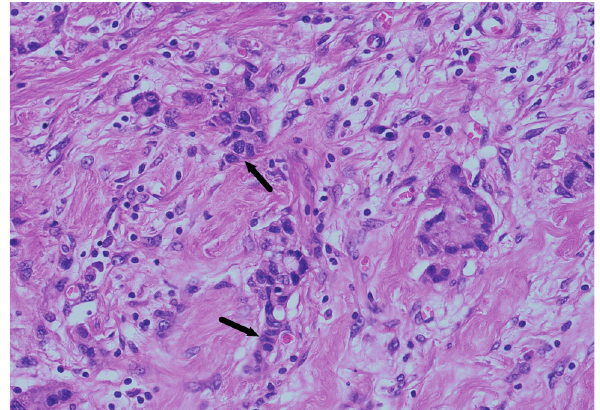
Fig. 2. Tumor GCC transforms into adenocarcinoma ex-goblet cell carcinoid (arrows point to adenocarcinoma cells) (HE, 200x).